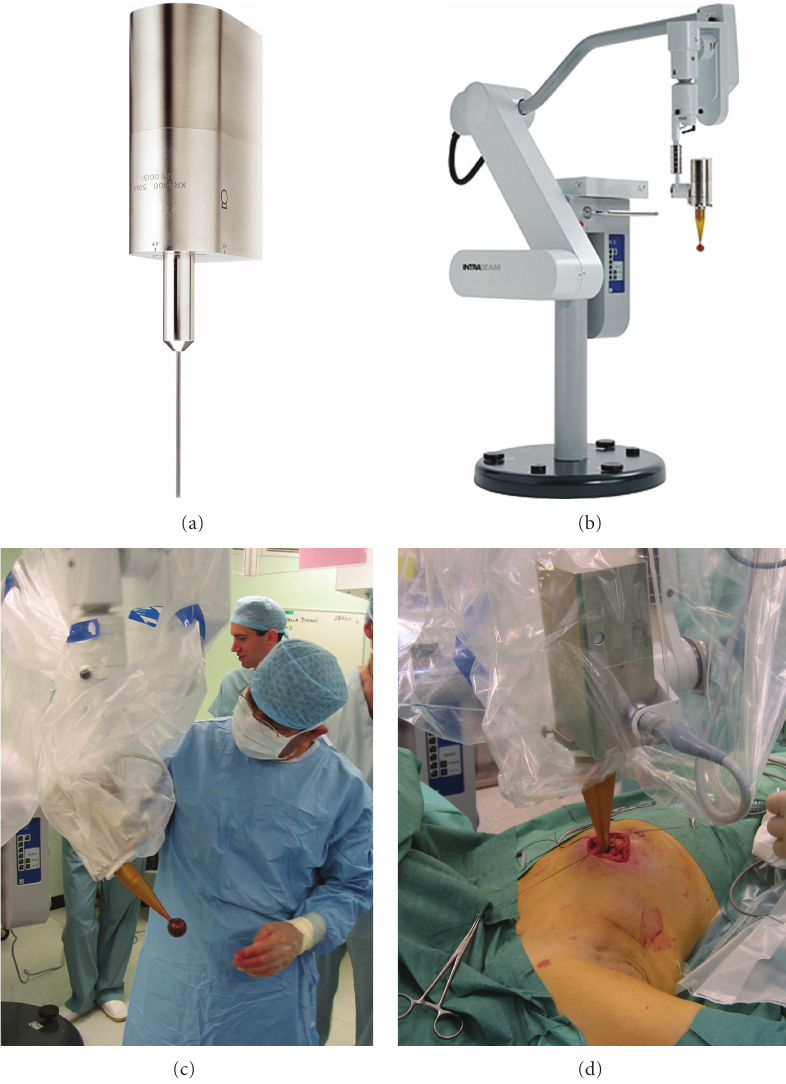
Figure 1: (a) The portable X-ray accelerator (Intrabeam). Soft X-rays are produced at the tip of the drift tube. (b) The intrabeam device mounted on the stand. The unit is portable and can be moved into the operating theatre as and when required. (c) Sterile drape and applicator in place, ready for positioning by the surgeon. (d) The applicator has been placed in the tumour bed and a purse-string suture is being applied to ensure conformity of the tissue to the